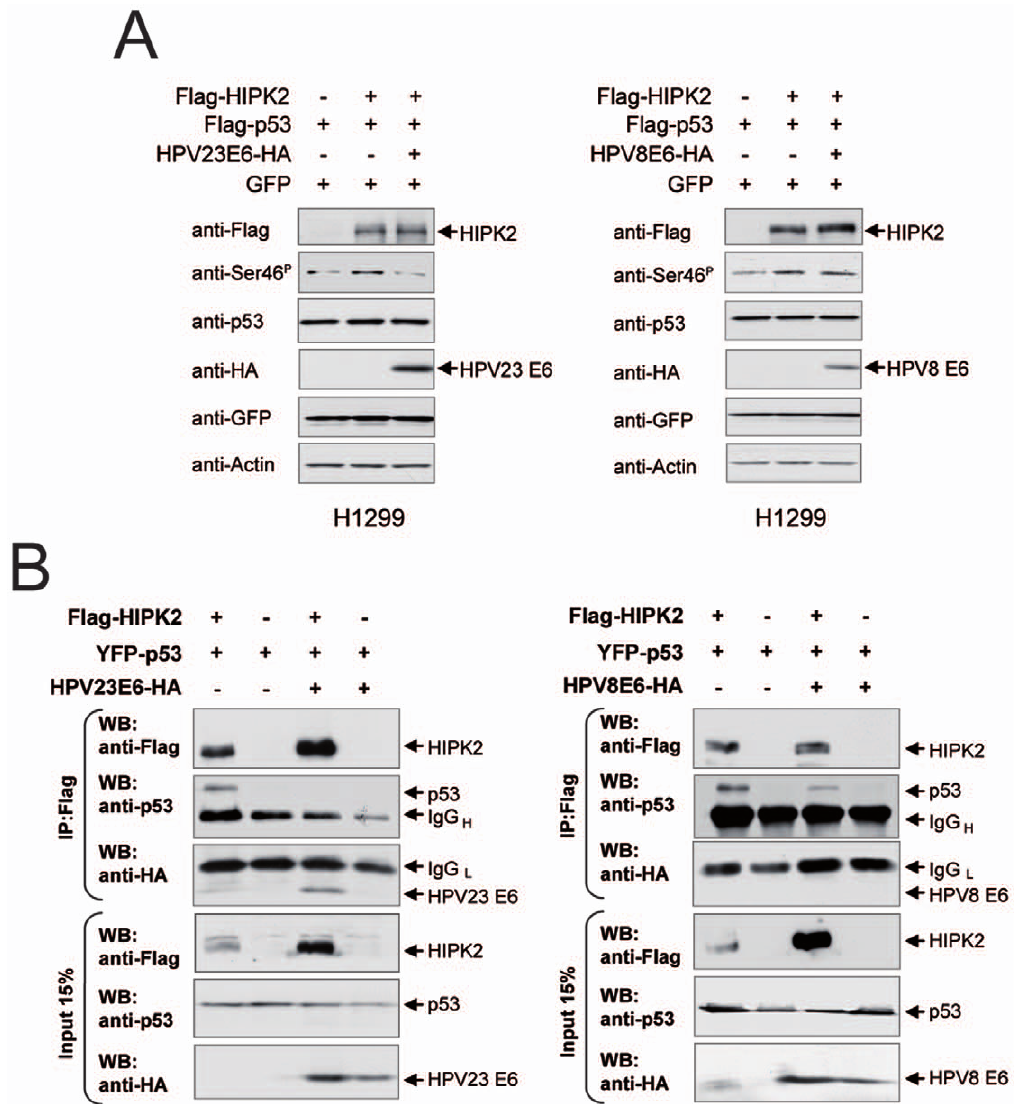
Figure 4. HPV23 E6 proteins dissociate the HIPK2/p53 complex and inhibit HIPK2 phosphorylation of p53 at Ser 46. Western blot analyses of transfected p53-negative H1299 cells with HPV23 E6-HA and/or Flag-HIPK2 and/or Flag-p53 (A and B) or YFP-p53 (B). ( A ) HPV23 E6 expression reduces HIPK2 phosphorylation of p53 at Ser 46 shown by Western blot. HPV8 E6 proteins, which do not bind HIPK2, have no effect on p53 phosphorylation at Ser 46. ( B ) HPV23 E6 proteins dissociated the HIPK2/p53 complex formation. Immunoprecipitation (IP) with Flag antibody (M2) of transfected H1299 cells (see above) to examine in vivo binding of HIPK2 with p53 in the presence or absence of HPV23 E6. To examine protein expression in H1299 (lower panels), 15% of cell lysates were analyzed by Western blot. The light and heavy chains of the precipitating antibody (IgG L and IgG H ) are indicated.